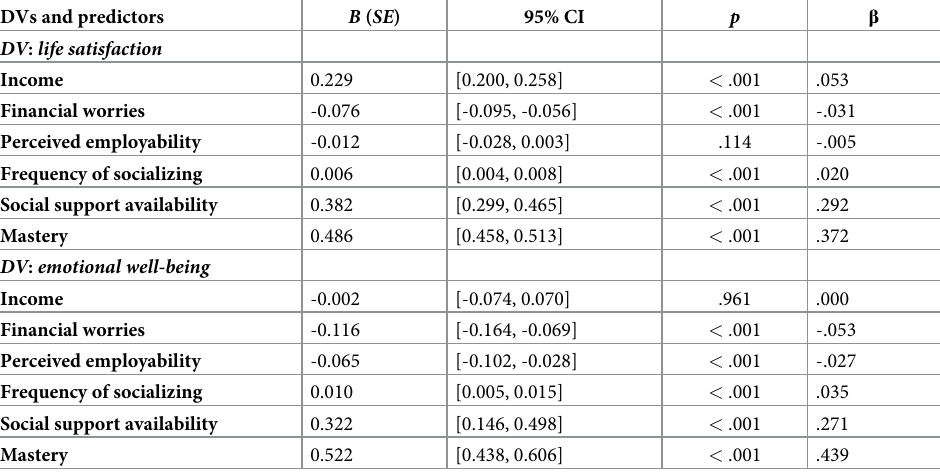
Table 4. Within-level effects of resources on SWB (second stage of